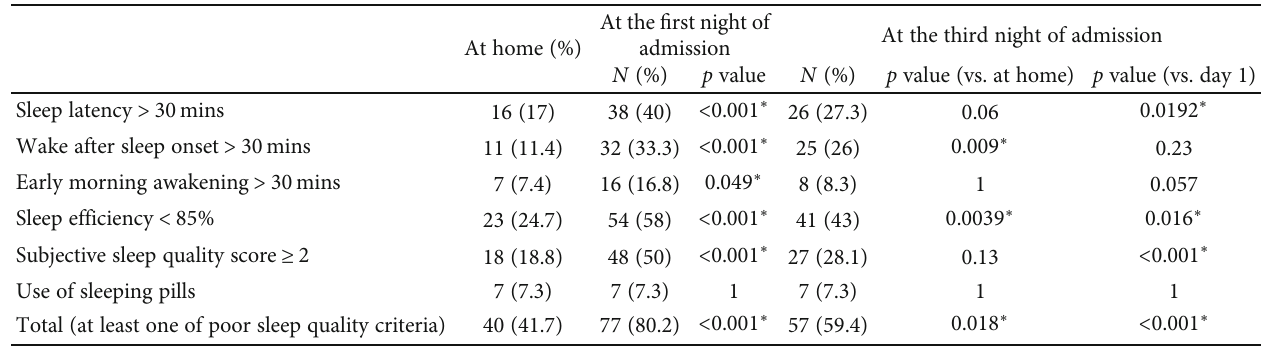
Table 2: Prevalence of poor sleep quality (all wards).